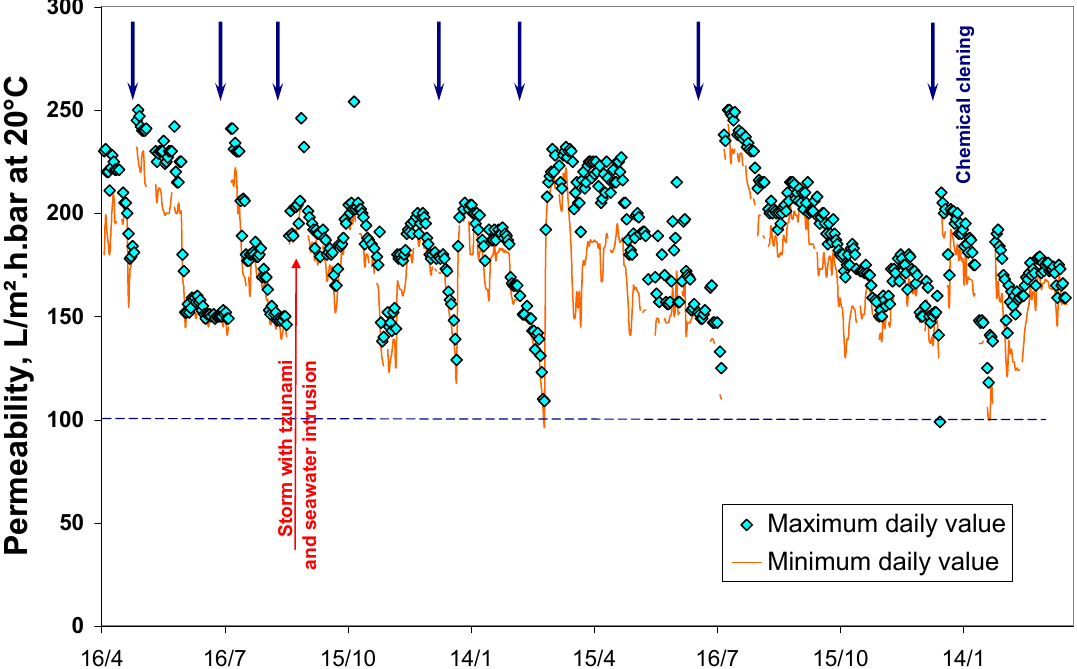
Figure 4. Evolution of normalized membrane permeability (minimum and maximum daily